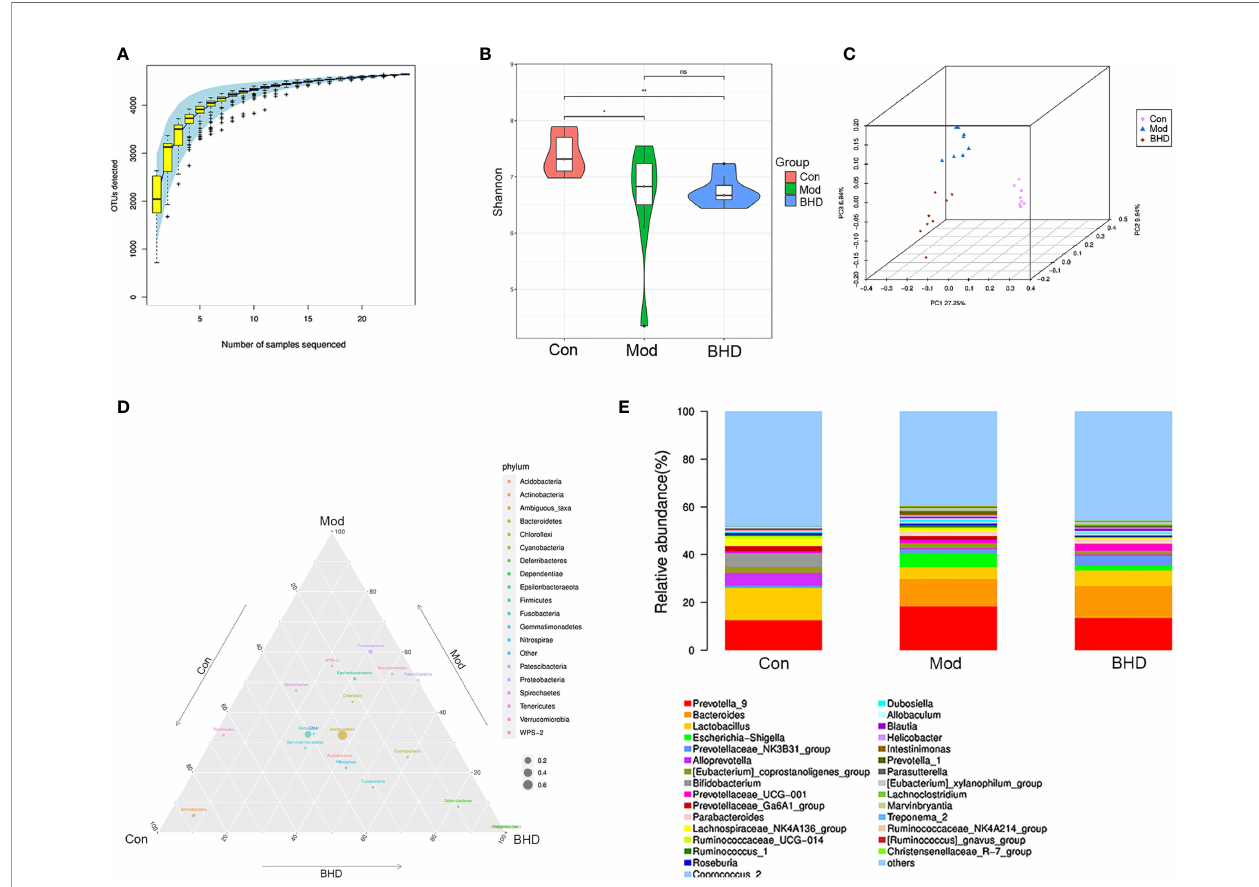
FIGURE 3 | BHD modulated the overall structure and composition of the gut microbiota in rats with CI. (A) Species accumulation curve. (B) Shannon diversity index. (C) PCoA based on unweighted UniFrac distances. (D) Ternary phase diagram. (E) Community structure bar plot at the genus level. ** p < 0.01, * p < 0.05. ns, not statistically signi fi cant. Con, control group; Mod, model group; BHD, BHD group. n = 8 per